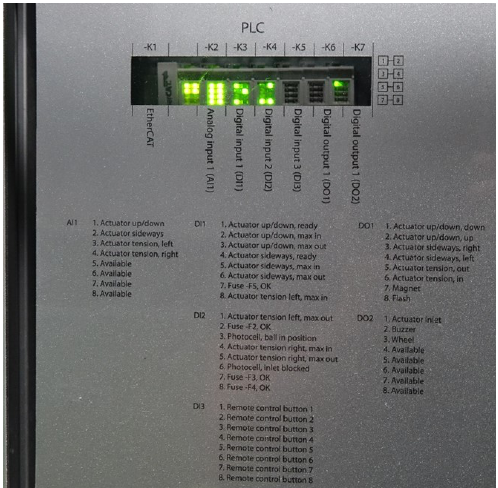
Figure 8. Ball Training Machine—programmable logic controller